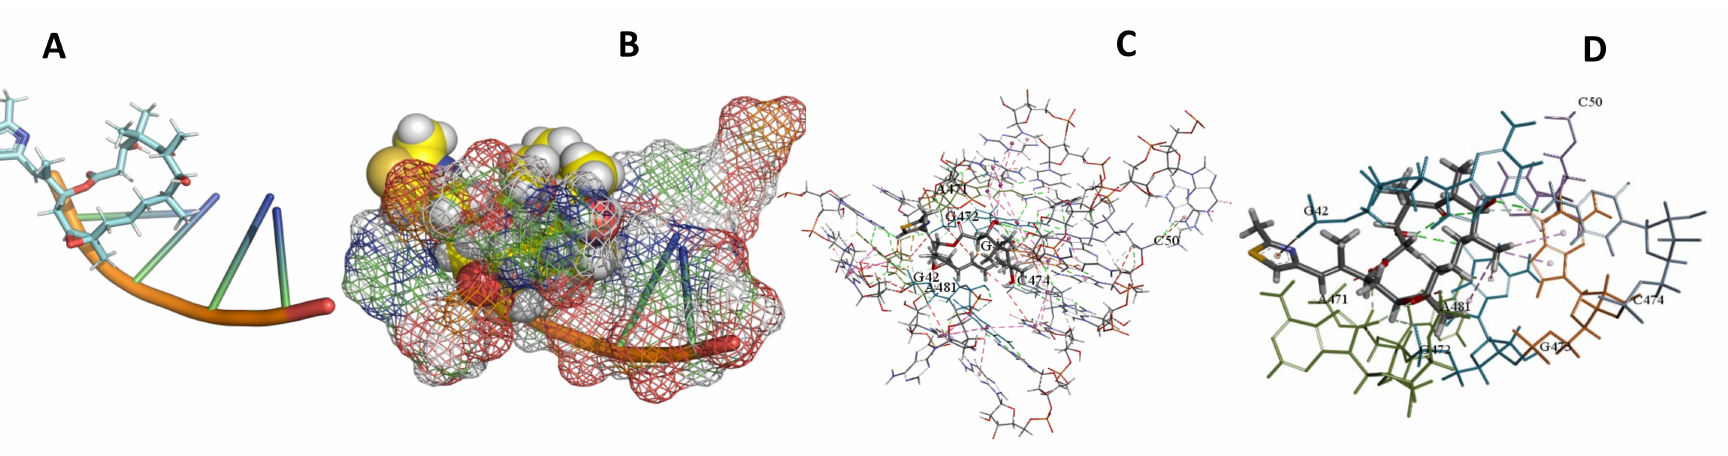
Figure 21. L. major + Epothilone. ( A ): Best binding pose and nucleotides involved. ( B ): Schematic binding pocket. ( C ): shows the Nucleotides component that re involved in binding. ( D ): Shows the main bonds involved between the compound and the nucleotide